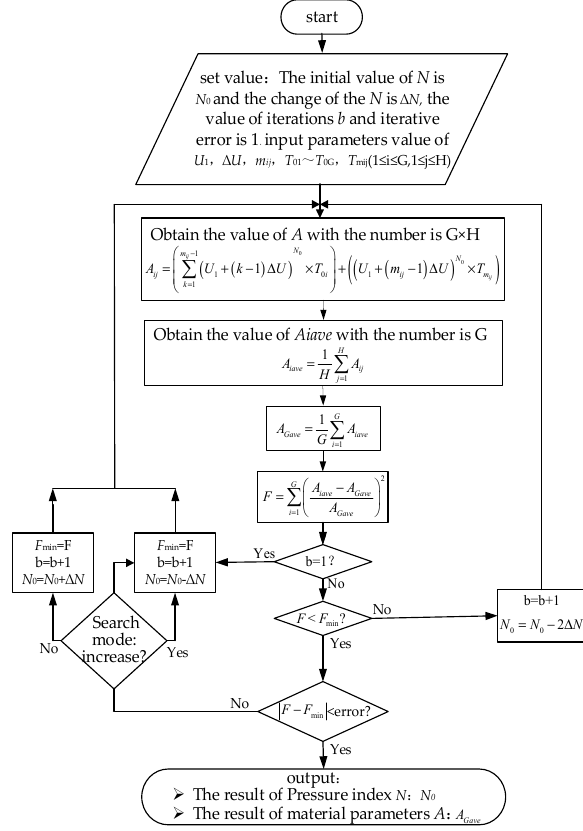
Figure 7. The process of solving for N and A.